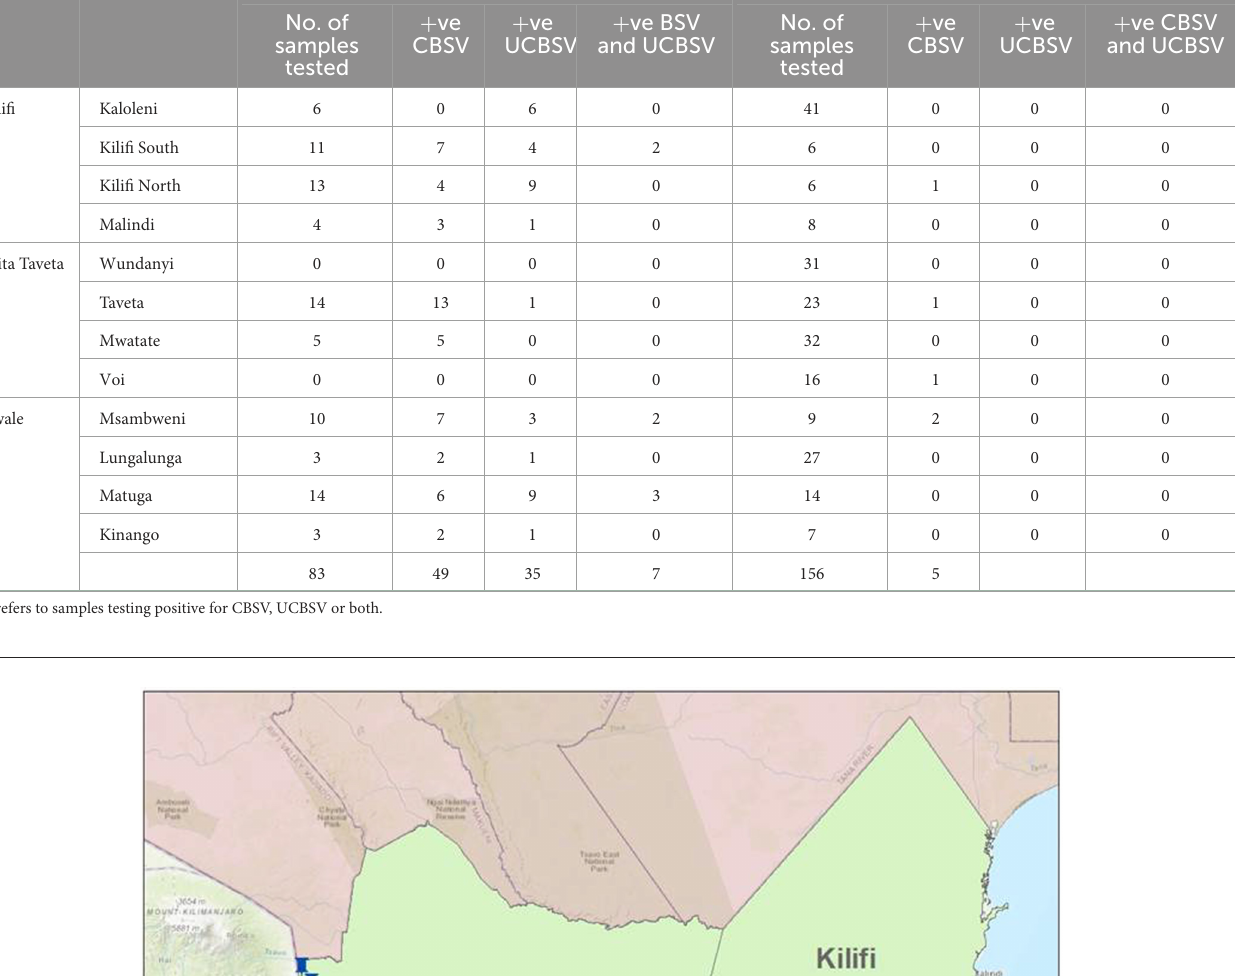
major pests observed on cassava farms with 94.2% and 77.5% in Kilifi and Taita Taveta Counties, respectively, in coastal Kenya. The whitefly ( Bemisia tabaci ) has been reported to transmit viruses that cause the devastating cassava brown streak disease (Maruthi et al.,